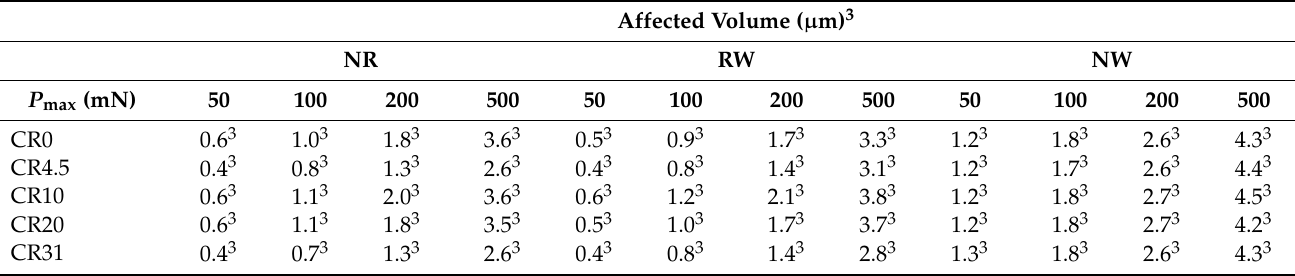
Figure 10. Schematic potential energy landscape (PEL) model illustrating different metastable energy states in the glassy phase. Table 4. The affected deformed volume in CR specimens during nanoindentation on the NR, RW, and NW planes at different P max .